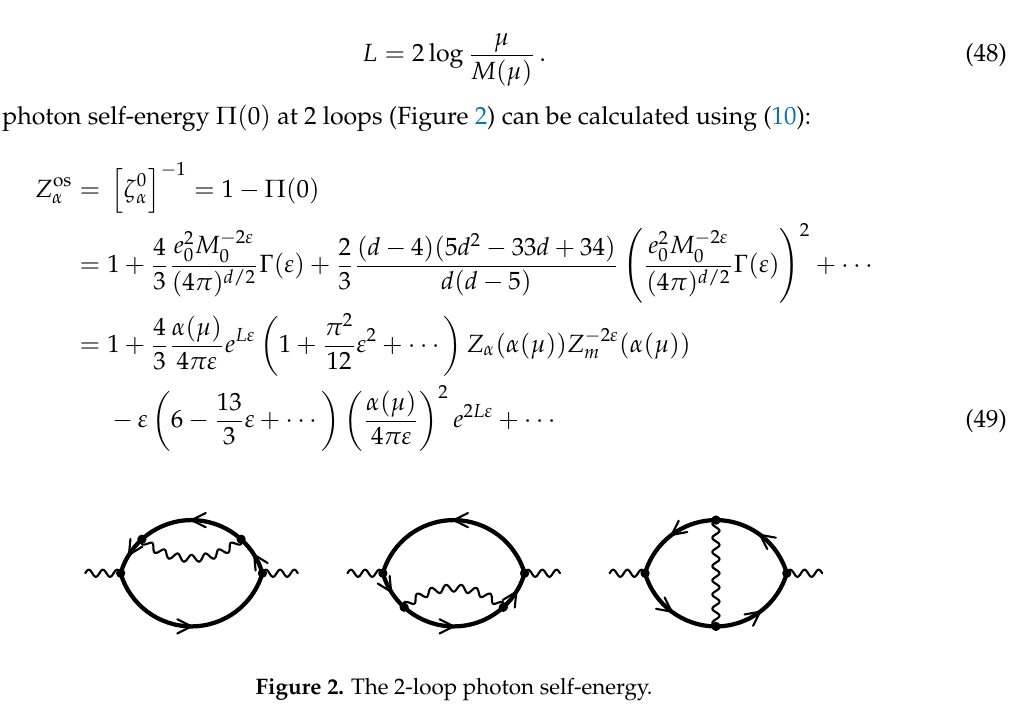
Figure 2. The 2-loop photon